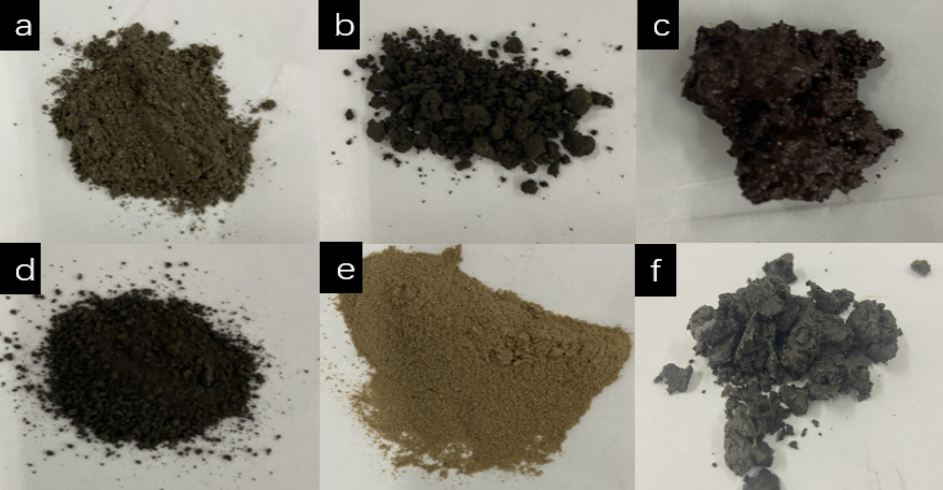
Figure 1. Morphology of scale samples from six gas wells.